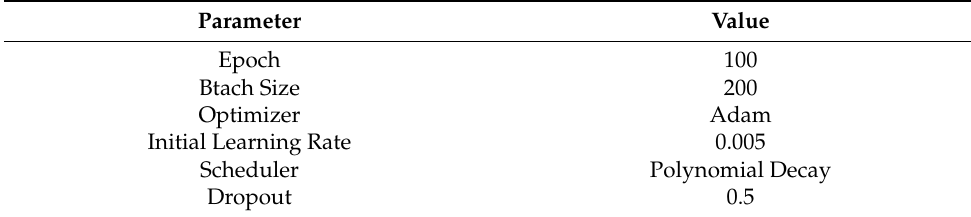
Table 3. Network Hyperparameter.